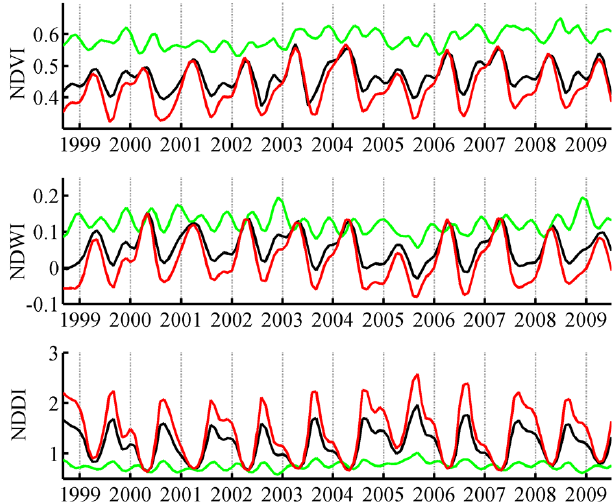
Fig. 2. Monthly time series (1999–2009) of NDVI (top panel), NDWI (central panel) and NDDI (lower bottom panel) averaged over Iberian Peninsula for all pixels (black line), for pixels of non-irrigated arable land (red line) and for pixels of needle-leaved forests (green line). Black arrows indicate the drought episode of 2005. Vertical dotted lines identify the month of